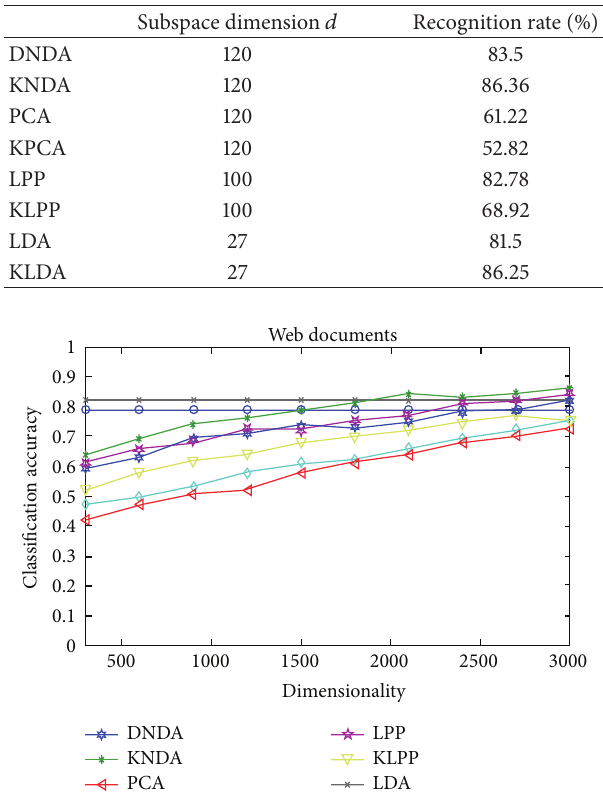
Table 2: The best recognition rate achieved by each method along with the corresponding subspace dimension 𝑑 .